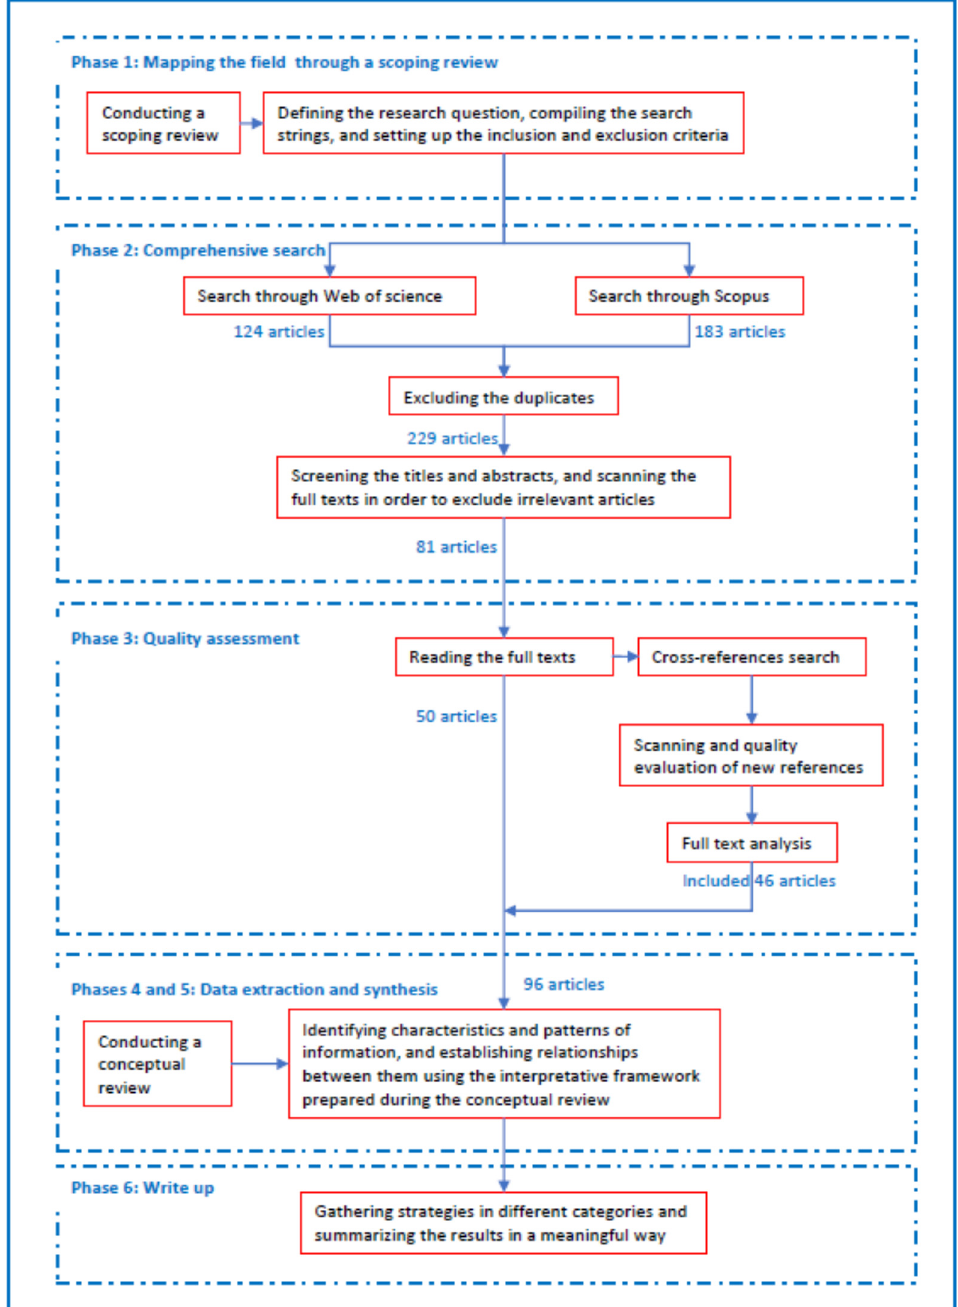
Figure 2. The flow diagram for the conducted systematic review. Table 2. A list of the publications per measure. Some of the studies include more than one meas- ure.